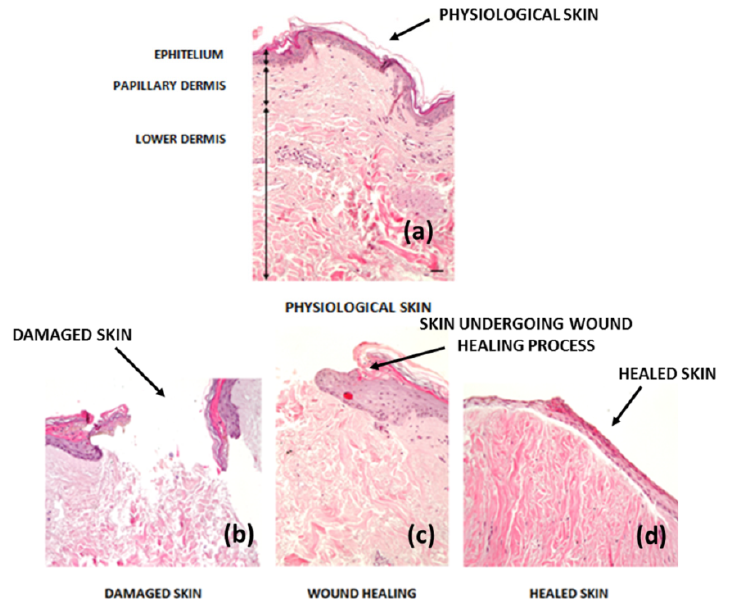
Figure 1. Histological image—hematoxylin–eosin stages of the wound healing process (10×, bar: 20 µm) ( a ) physiological skin, ( b ) damaged skin, ( c ) skin undergoing wound healing process and ( d ) healed skin [19] .